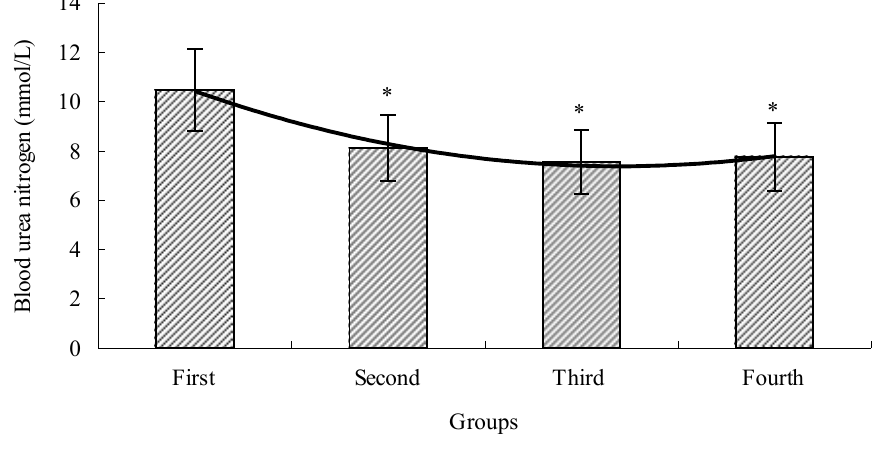
Figure 3. The effects of TBE on blood urea nitrogen of mice. Values are means ± SD. * P < 0.05 when compared to the control group (first